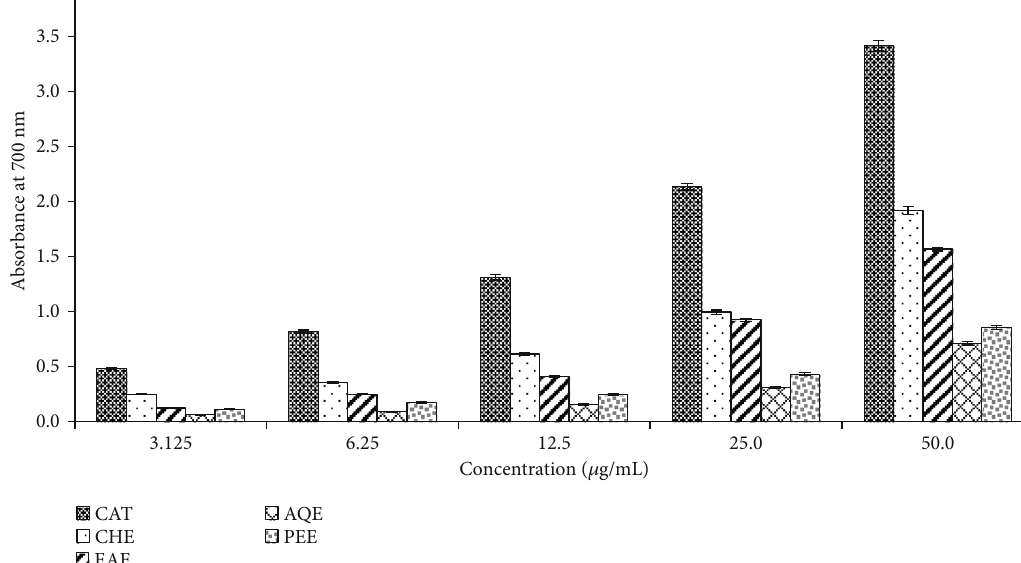
Figure 4: Reducing power of di ff erent extracts of E . fl uctuans . Results represent mean ± SD ( n = 3 ). Catechin (CAT) was used as a reference standard. CHE: chloroform extract; EAE: ethyl acetate extract; AQE: aqueous extract; PEE: petroleum ether